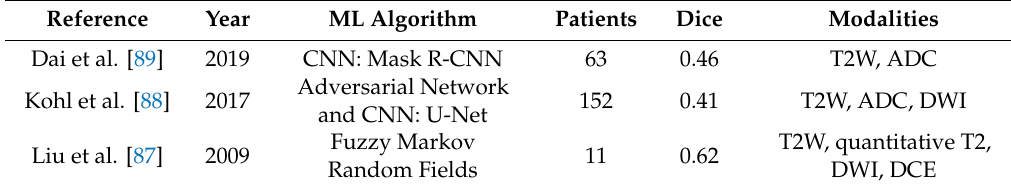
Figure 5. Prostate lesion segmentation using machine learning techniques. The computer takes multiparametric magnetic resonance imaging images of the prostate as inputs and applies the developed machine learning algorithm to correctly identify the borders of the lesion. Table 3. Machine learning techniques applied to prostate lesion segmentation.